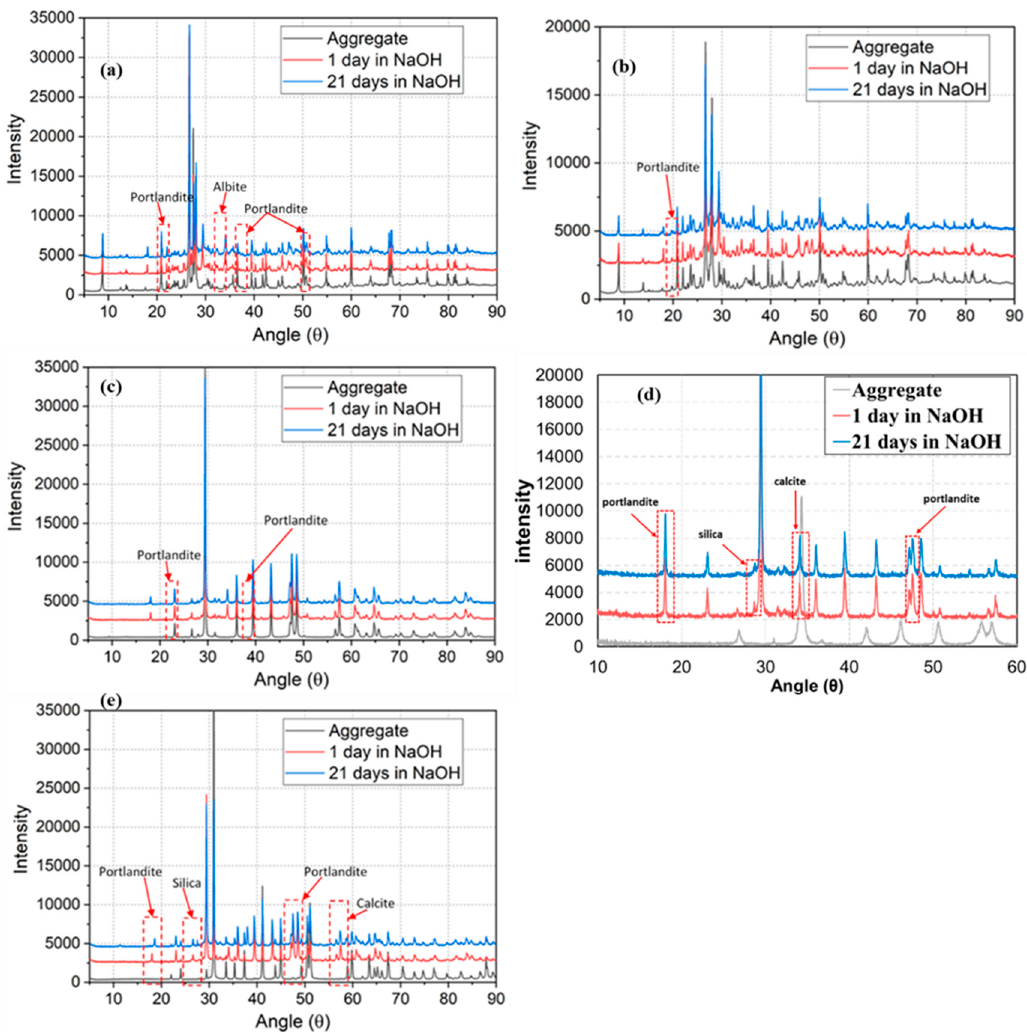
Figure 8. XRPD intensity comparison between fresh aggregate and accelerated mortar sample for ( a ) granite, ( b ) rhyodacite, ( c ) Bathurst limestone, ( d ) Ilam limestone, and ( e ) dolomite.